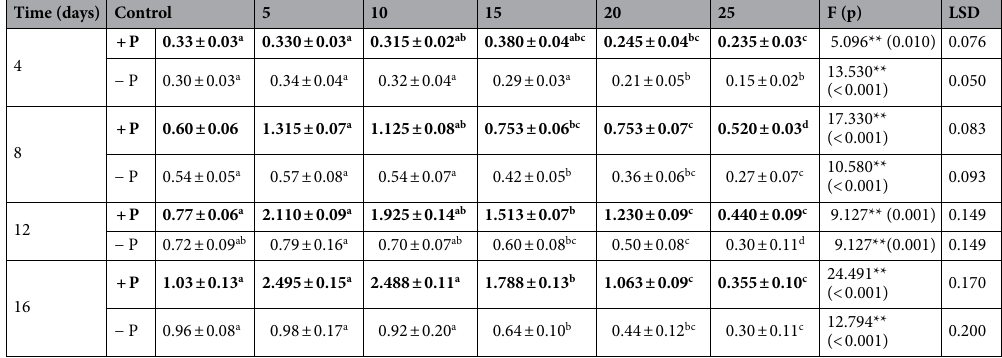
Table 1. Effect of different concentrations of dissolved nickel (mg/L) on growth measured as optical density of phosphorus supplemented and starved cells of Dunaliella tertiolecta . F F test (ANOVA), Least significance difference at 0.05. *Statistically significant at p ≤ 0.05. **Statistically significant at p ≤ 0.001. Different superscripts are